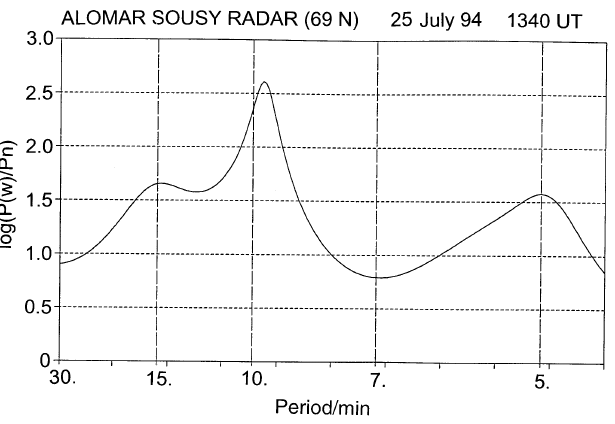
Fig. 3. Maximum entropy spectrum of the vertical velocity mea- sured at a height of 86 km for the 90-min observational period, starting at 1340